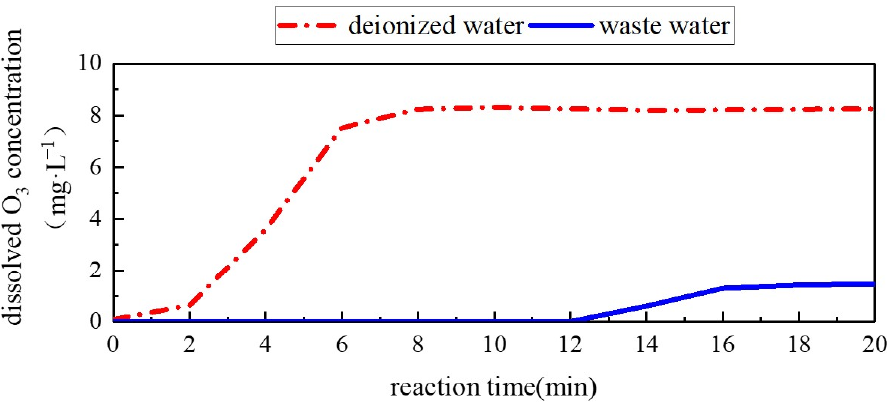
Figure 4. Ozone concentration (liquid) curve under the combined action of ozone (25 g·m − 3 ) and manganese dioxide as catalysts (6 g·L −1 ).